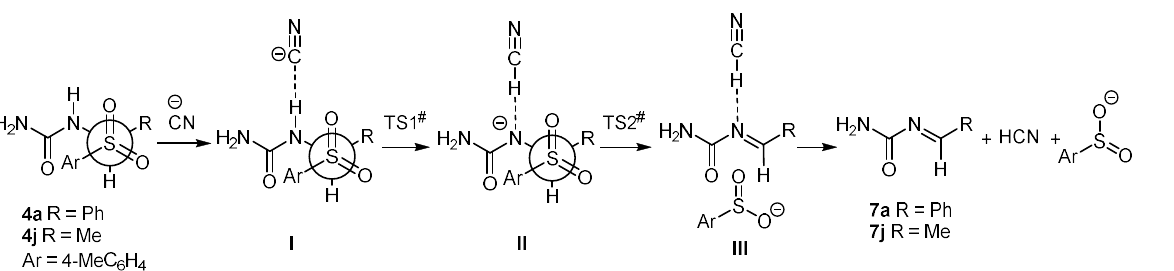
Table 3. Relative electronic energy (ΔE), Gibbs free energy (ΔG), C-S and C-N bond lengths in N-C- S fragment for three rotamers of compounds 4a and 4j in DMF solution a